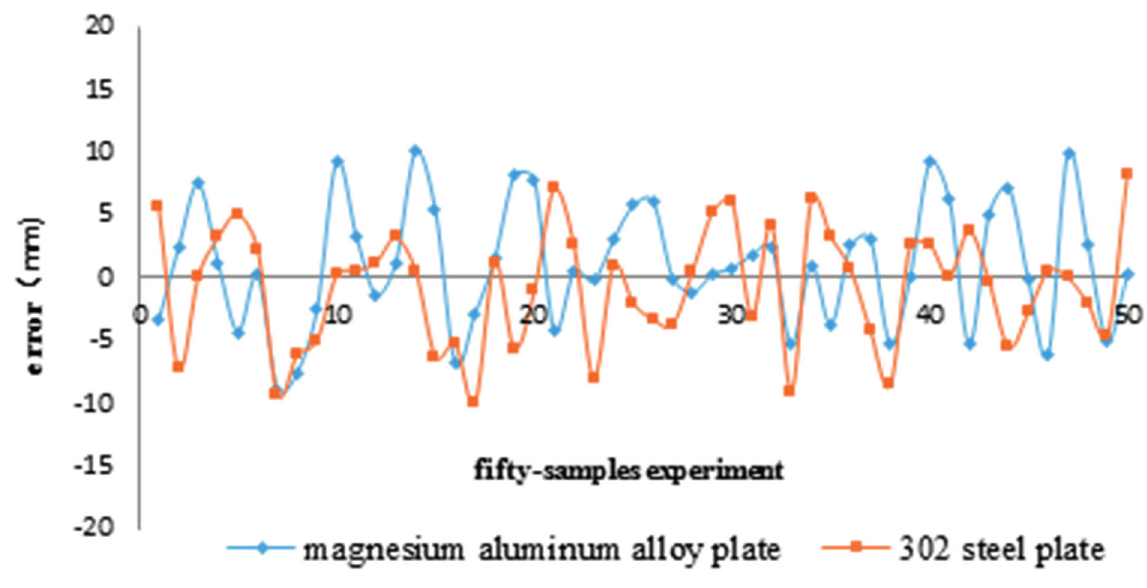
Figure 14. Position